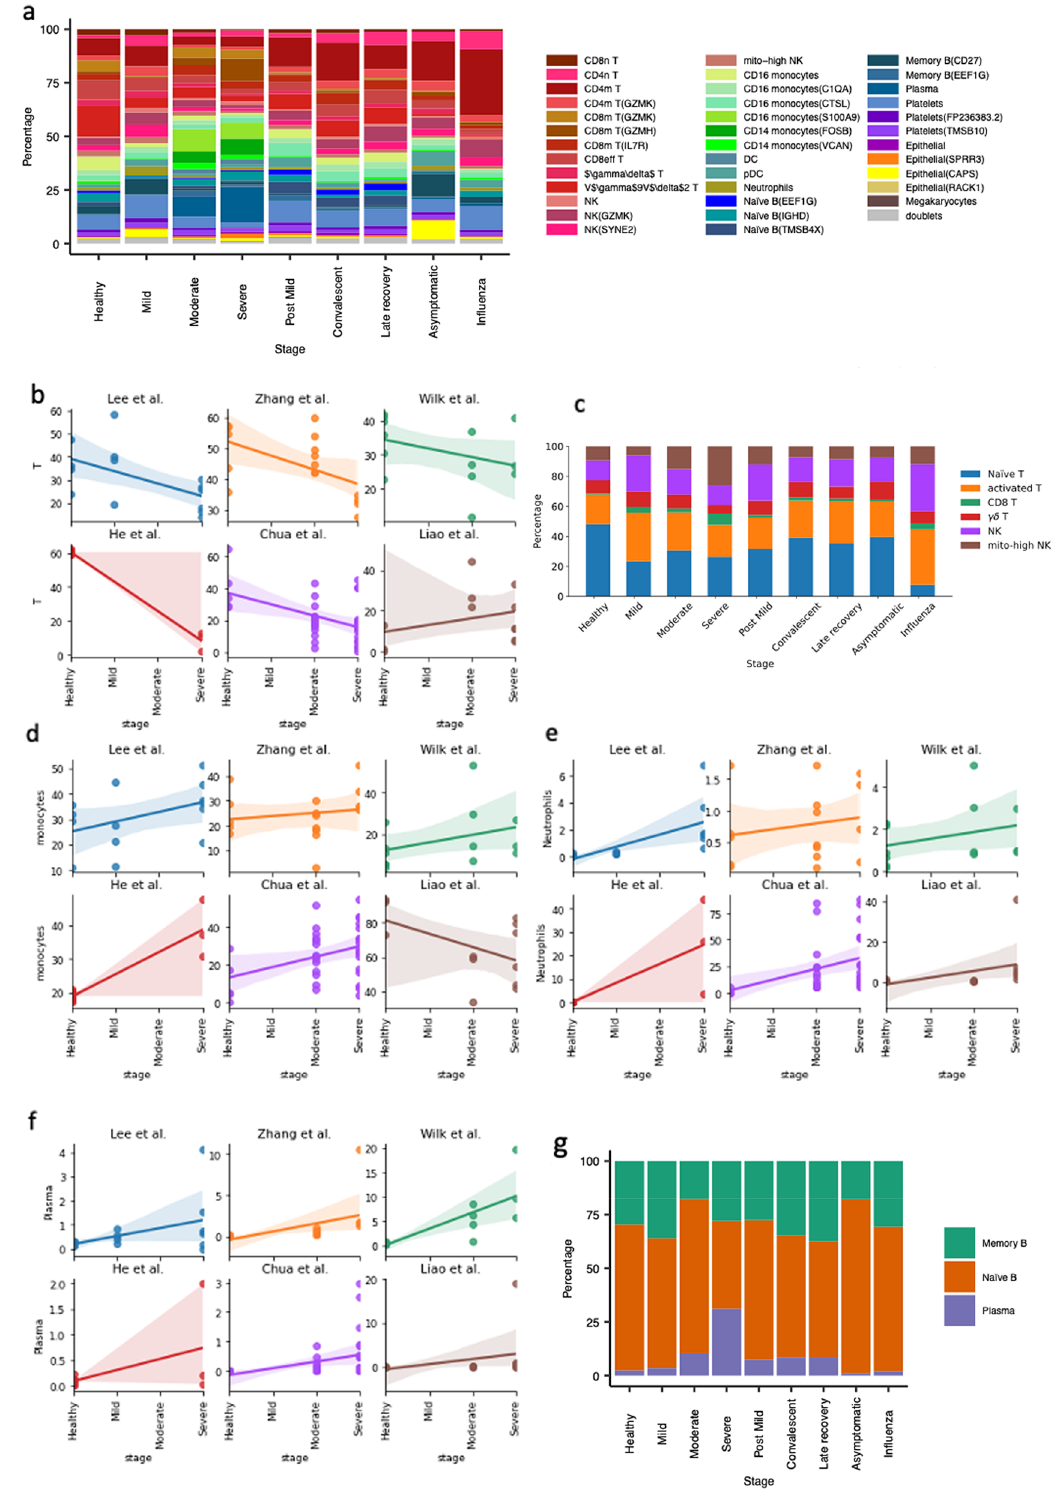
Figure 3. Cell type proportion change upon SARS-CoV-2 infection revealed by multiple studies. ( a ) The general distribution of the cell subpopulations at different disease stages; ( b,d–f ) The cell proportion changes upon disease stages for T cells, monocytes, neutrophils and plasma cells, respectively, in different studies. ( c–g ) The general distribution of T-cells/Natural killer (NK) cells and B-cells, respectively, across